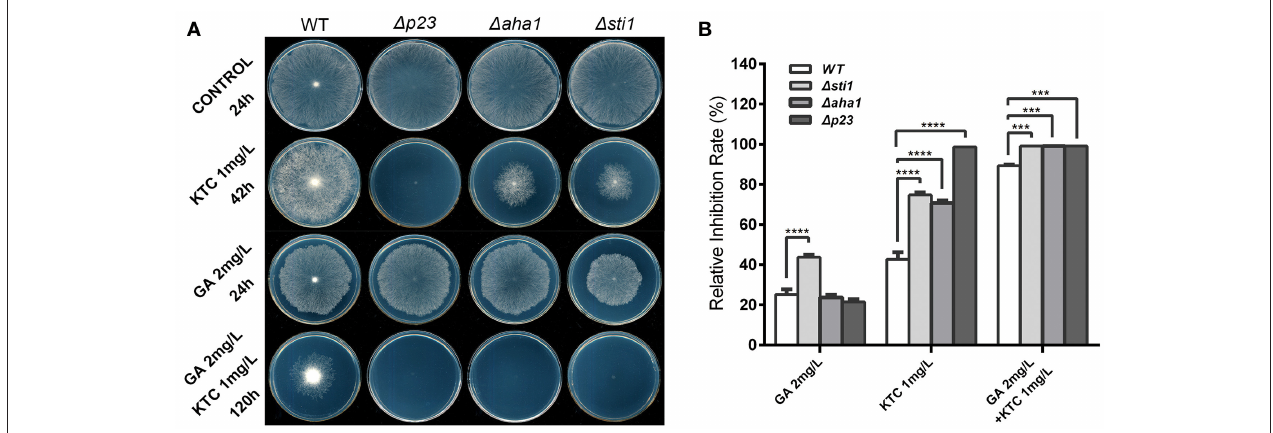
FIGURE 3 | Susceptibility tests of N. crassa to ketoconazole, the Hsp90 inhibitor geldanamycin and the two drugs combined. (A) Susceptibility tests with geldanamycin (GA, 2 mg/L), ketoconazole (KTC, 1 mg/L) or the two drugs combined. Two microliters of conidial suspension (2 × 10 6 conidia/ml) were inoculated in the center of plates ( 8 90mm) with or without antifungal drugs or oxidants, and then incubated at 28 or 42 ◦ C (heat tests) for the indicated time. (B) Relative growth inhibition rates were calculated based on colony diameters at 24h after drug treatment. Values from three replicates were used for a statistical analysis. Means of the inhibition rates are shown, and standard deviations are marked with error bars. Differences between the mutants and the WT were statistically analyzed by the analysis of variance. Values with P < 0.0001, 0.0001 < P < 0.001, 0.001 < P < 0.01, and 0.01 < P < 0.05 are marked with ****, ***, ** and *, respectively.